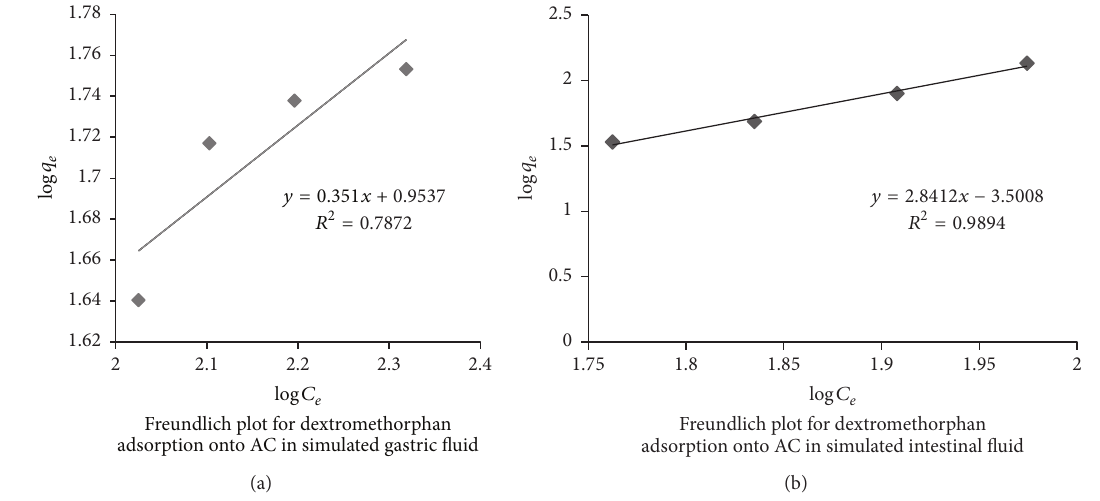
Figure 3: Freundlich plot of AC with DXM in (a) simulated gastric fluid and (b) simulated intestinal